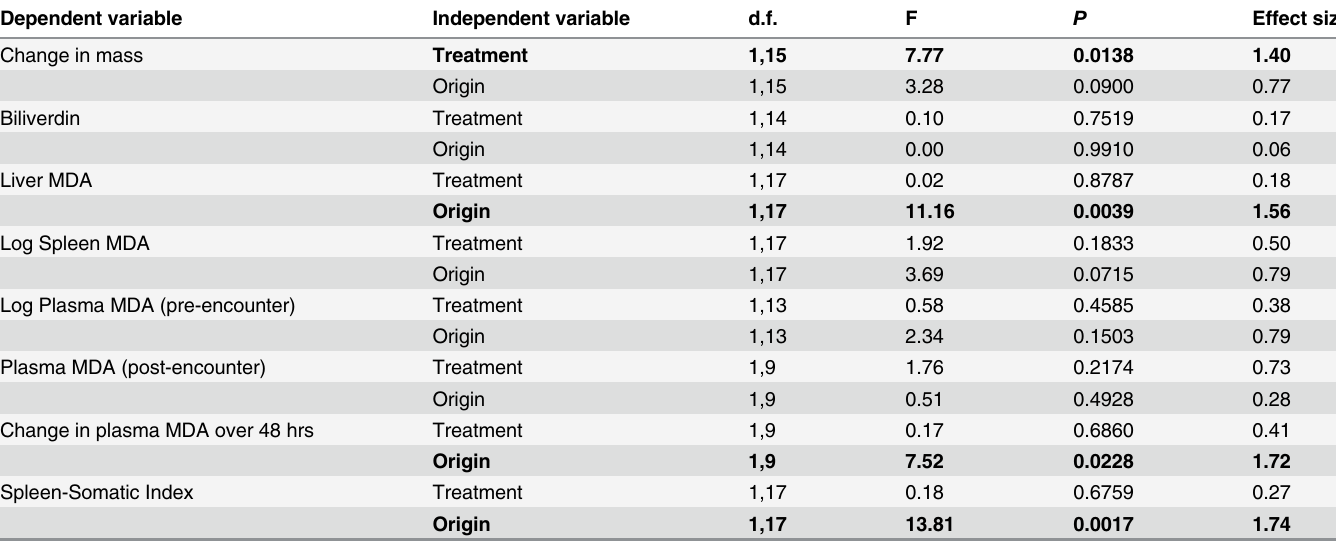
Table 1. Effect of treatment on multiple metrics of chameleon